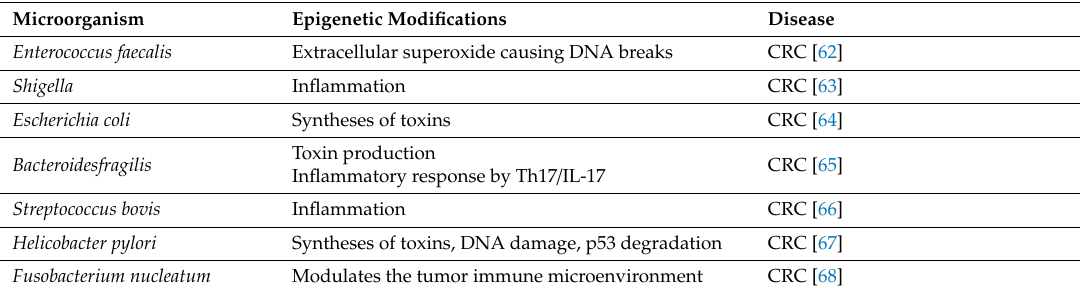
Table 1. Overview of bacteria which are associated with di ff erent types of